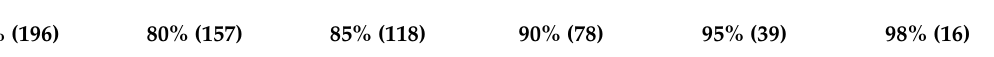
Table 7. Comparison of MNIST reconstruction accuracy and SSIM.